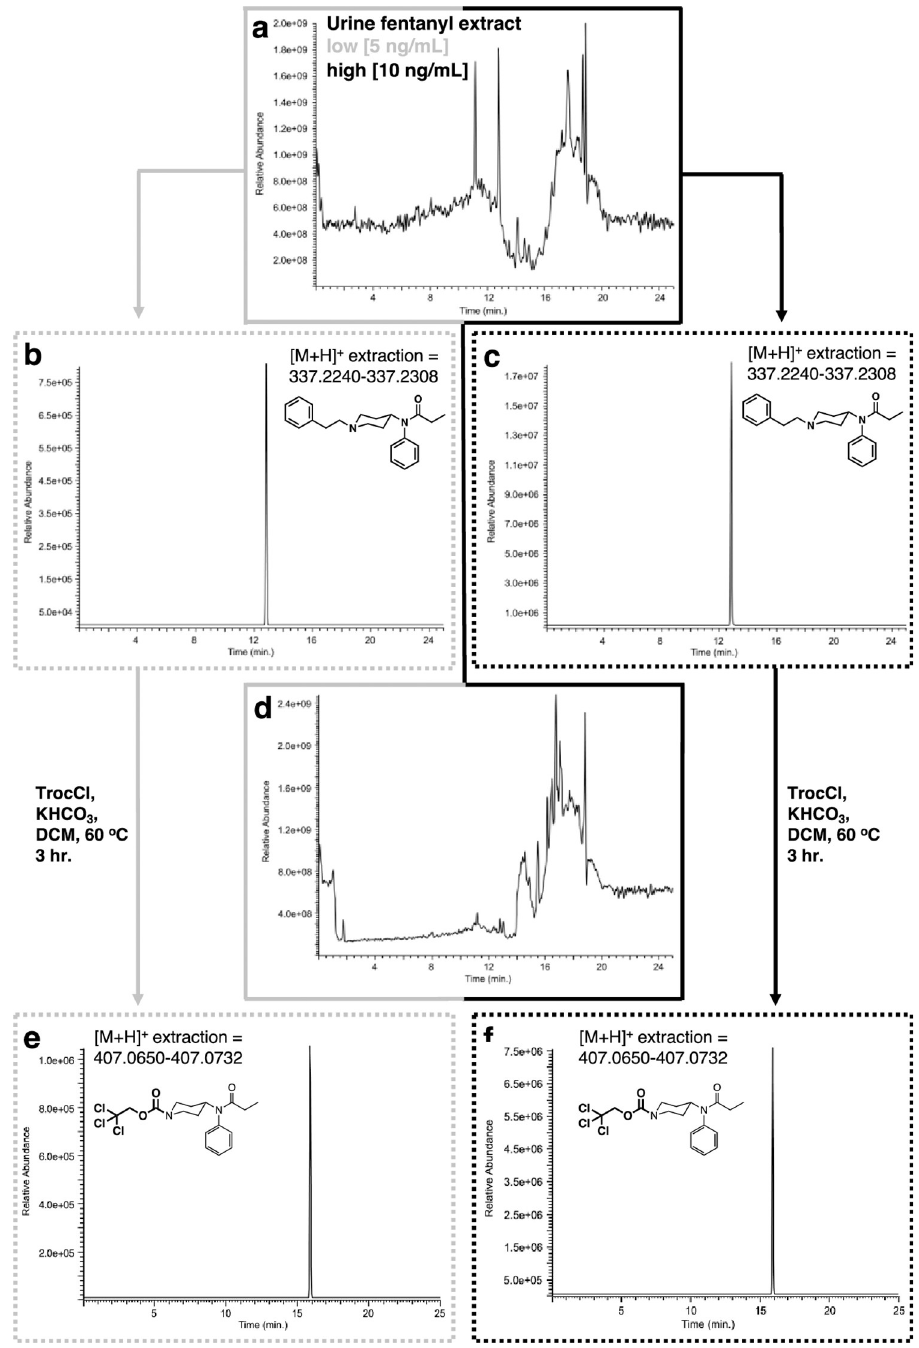
Fig 12. Analysis by HR-LC-MS of extraction and reaction of fentanyl with Troc-Cl when spiked in urine. (a) Ion chromatogram of extracted urine sample; (b) extracted ion ([M+H + ] = 337.2274 ± 5 ppm) for fentanyl (rt = 13.85 min.) for low concentration urine sample (5 ng/mL); (c) extracted ion ([M+H + ] = 337.2274 ± 5 ppm) for high concentration in urine sample (10 ng/mL); (d) Ion chromatogram of reaction between extracted urine sample with Troc-Cl; (e) extracted ion ([M+H + ] = 407.0691 ± 5 ppm) for Troc-norfentanyl for low concentration spiked urine sample; (f) extracted ion ([M+H + ] = 407.0691 ± 5 ppm) for Troc-norfentanyl for the high concentration spiked urine sample showing its appearance at rt = 15.91